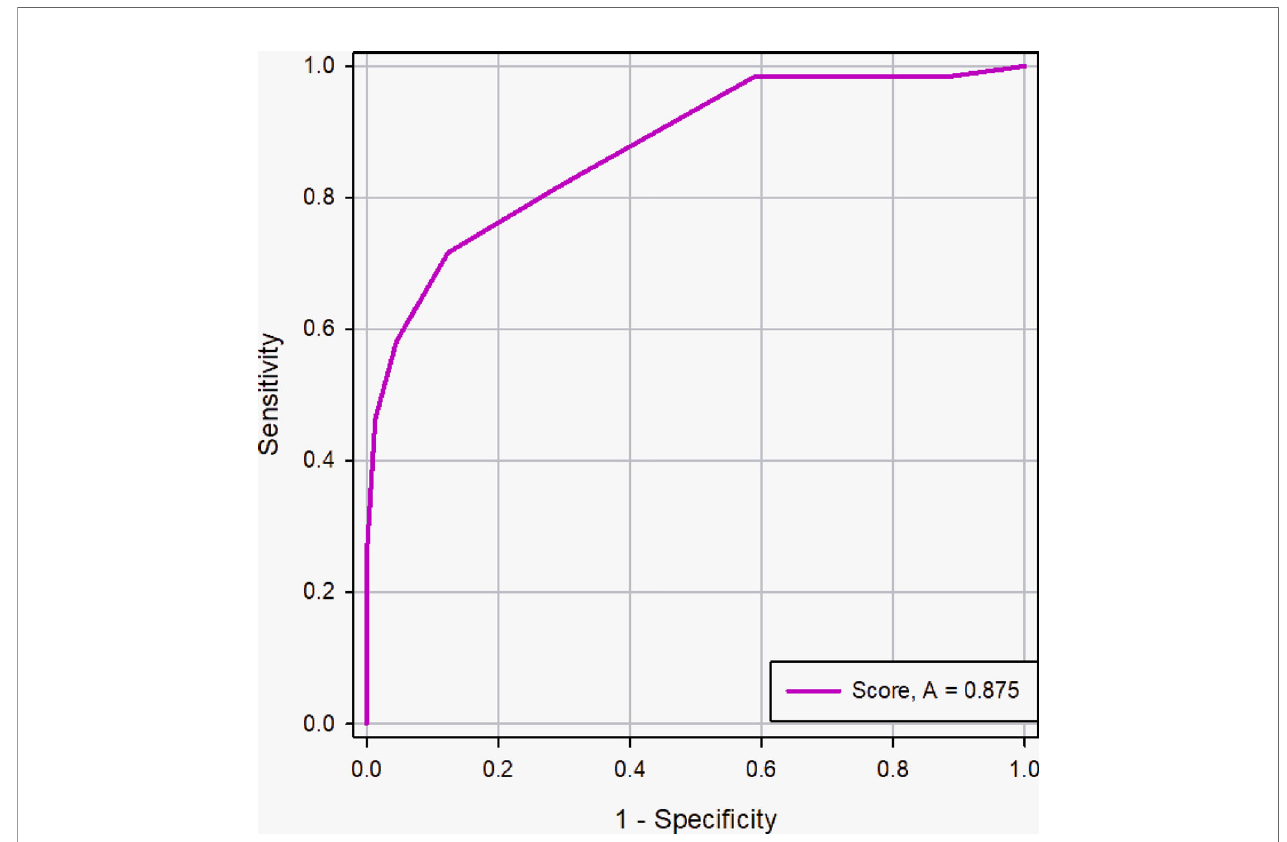
FIGURE 10 | ROC curve of the scoring system in the nodule size ≥ 2cm group. The AUC was 0.875 (95% CI: 0.824 - 0.915, p < 0.0001).